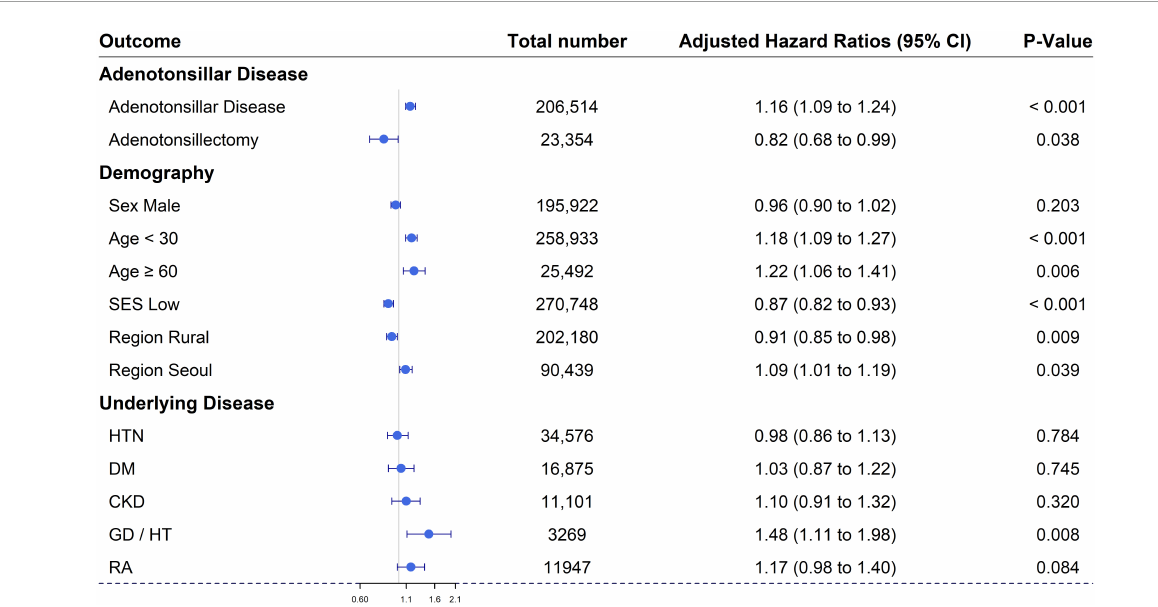
FIGURE3 Forest plot of the cumulative hazard ratio of each variable for the development of vitiligo. SES, socio-economic status; HTN, hypertension; DM, diabetes mellitus; CKD, chronic kidney disease; Thyroid, thyroid disease including Graves’ disease and Hashimoto’s thyroiditis; RA, rheumatoid arthritis.